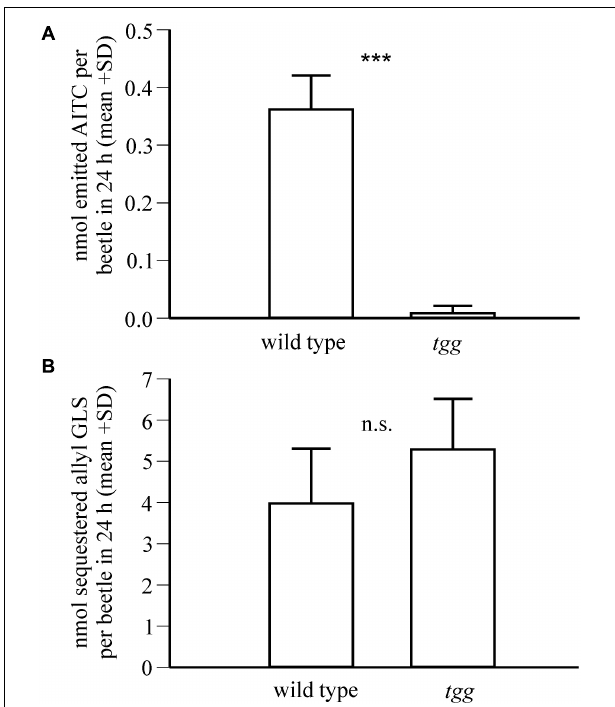
FIGURE 3 | Impact of plant myrosinase activity on allyl glucosinolate sequestration in P. armoraciae . Adult beetles were fed with allyl glucosinolate-spiked Arabidopsis leaves with (wild type) and without ( tgg ) myrosinase activity for 1 day ( n = 6–7 per plant genotype). (A) Headspace volatiles were collected on Porapaq-QTM adsorbent, eluted with hexane, and analyzed by gas chromatography-mass spectrometry. The amounts of emitted allyl isothiocyanate (AITC; m/z 99) were quantified using an external standard curve. Detected AITC amounts were corrected by subtracting the background emission detected in volatile collections performed without beetles, which served as controls. AITC amounts were compared by Mann-Whitney rank sum test (*** p < 0.001). (B) The amounts of sequestered allyl glucosinolate in beetles were quantified after conversion to desulfo-glucosinolate using an internal standard by HPLC-DAD. The amounts of allyl glucosinolate were compared by Student’s t -test and were not significantly different (n.s., p > 0.05). Results of statistical analyses are provided in Supplementary Table 1 .